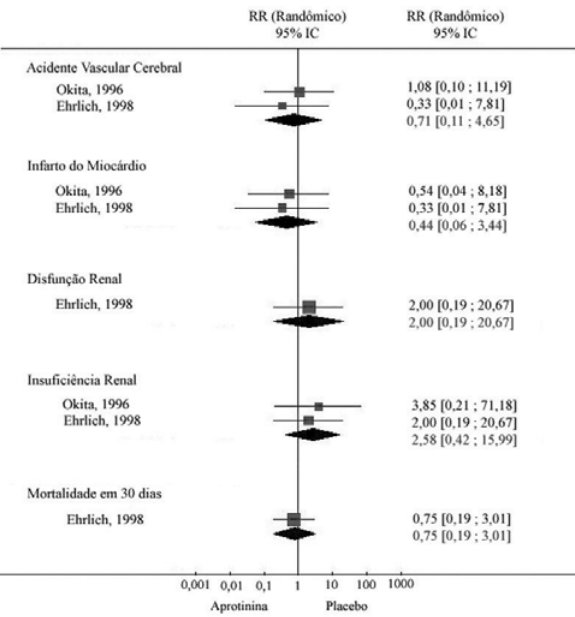
Fig. 4 - Metanálise das variáveis dicotômicas dos estudos que administraram baixa dose da aprotinina. RR = risco relativo; IC = intervalo de confiança